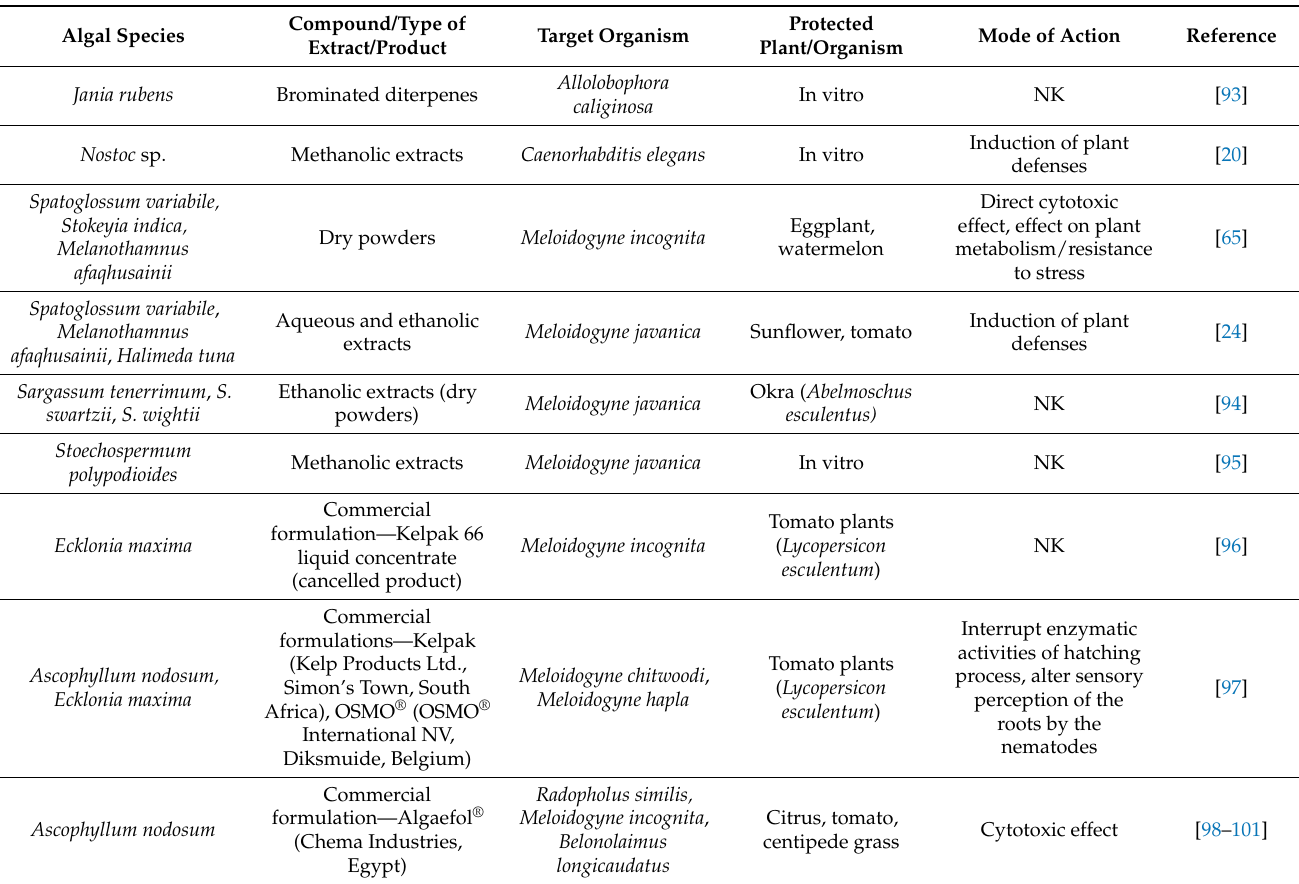
Table 4. Summary of algal products and their pesticidal activity against soil